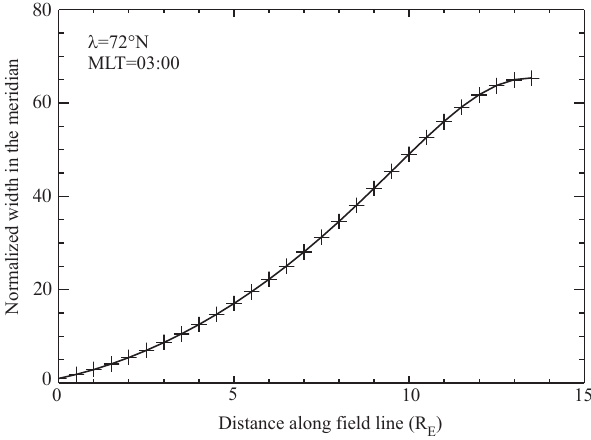
Figure 5. Element of field line separation in the meridian plane for a dipole magnetic field, normalized to the value at the Earth’s sur- face. The full line shows the values obtained by integrating the first order differential equations, while the crosses are obtained from the analytic